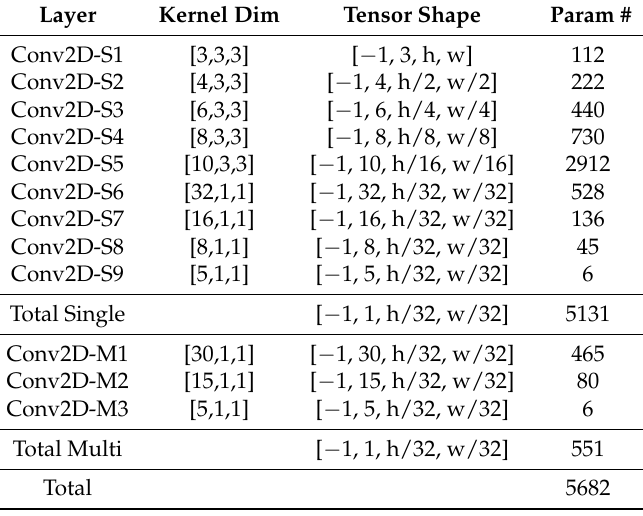
Table 3. Details of model architecture and number of parameters in each